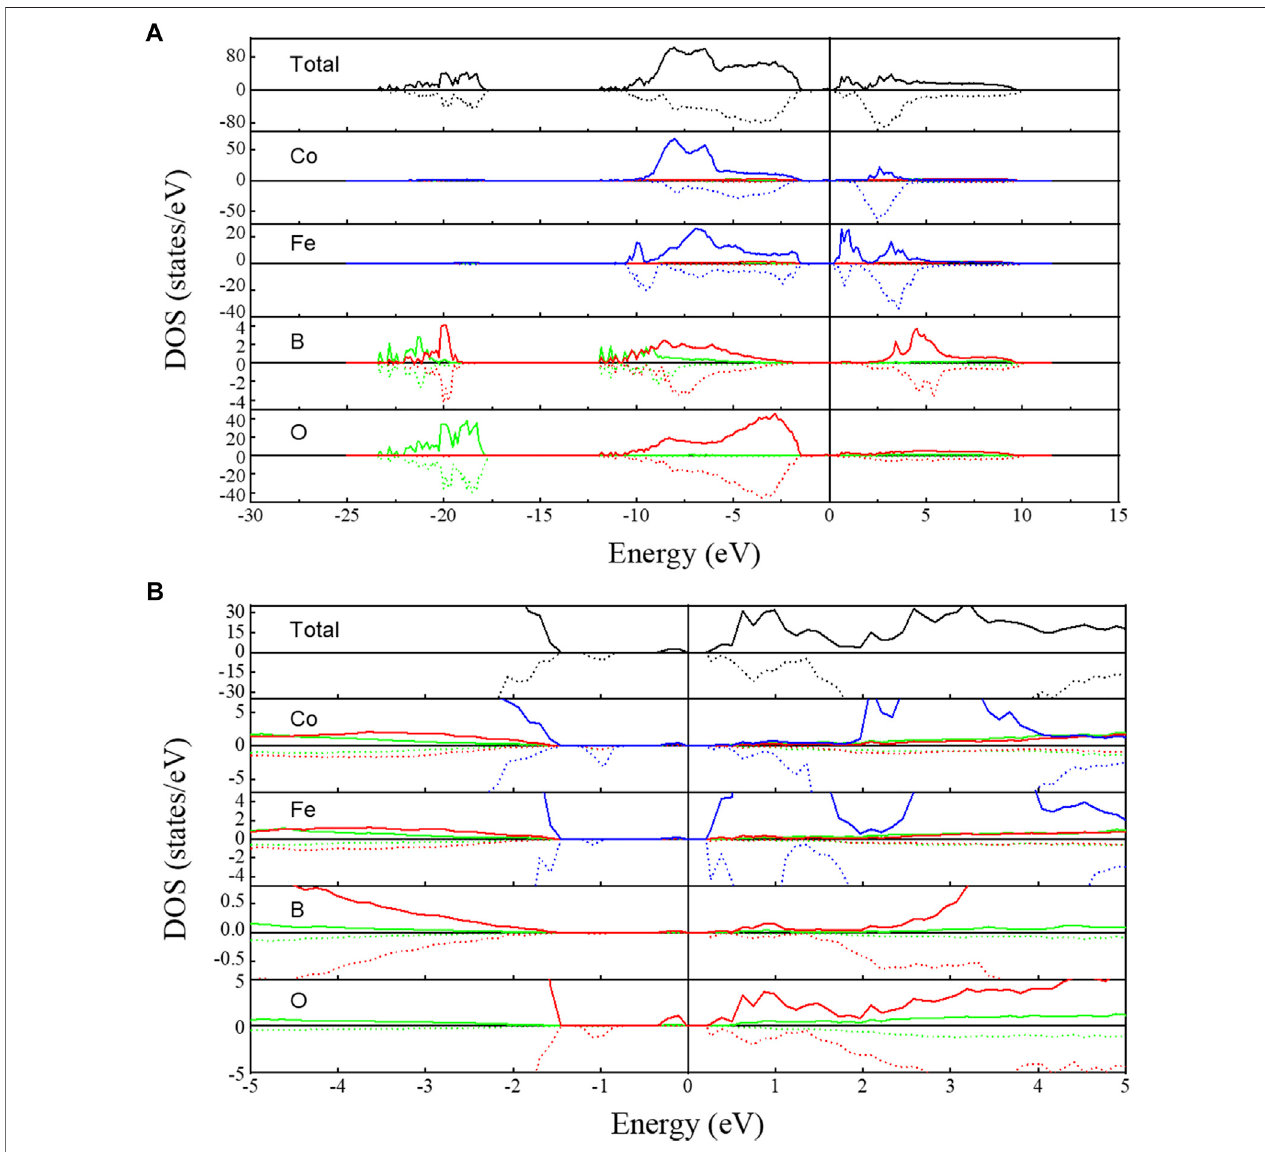
FIGURE 8 | (A) Total (the black curves) and partial DOS of Co-Fe-B-O amorphous oxide. (B) Enlarged image of DOS near Fermi level. The green, red, and blue curves represent the s , p , and d orbitals, respectively. Solid lines and dotted lines represent the spin-up and spin-down. The vertical line indicates the Fermi level.